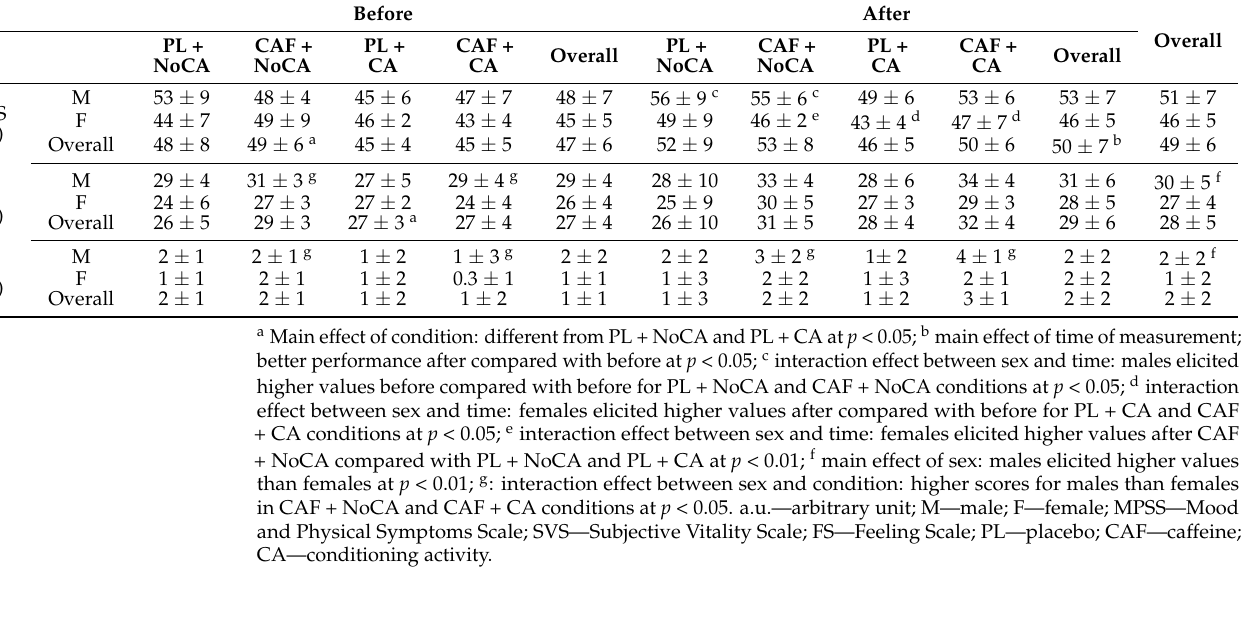
Table 2. Psychological responses before and after different conditions (values are mean ± SD; n =